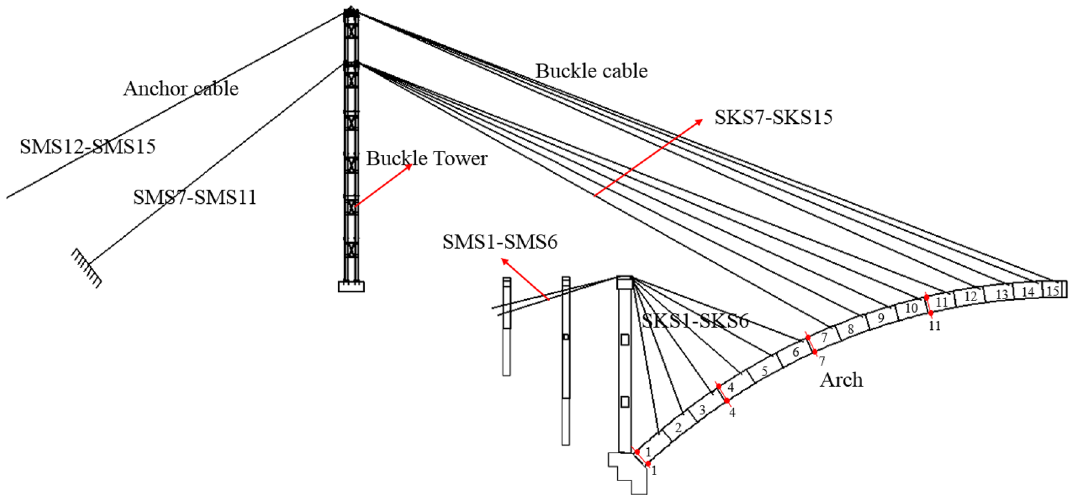
Figure 15. Strain monitoring